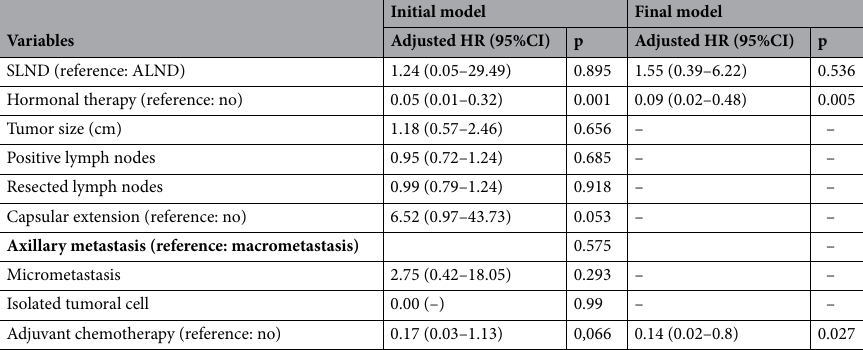
Table 4. Final survival analysis using Cox multivariate regression in patients with breast cancer. CI confidence interval, HR hazard ratio, SLND sentinel lymph node dissection, ALND complete axillary lymph node dissection.